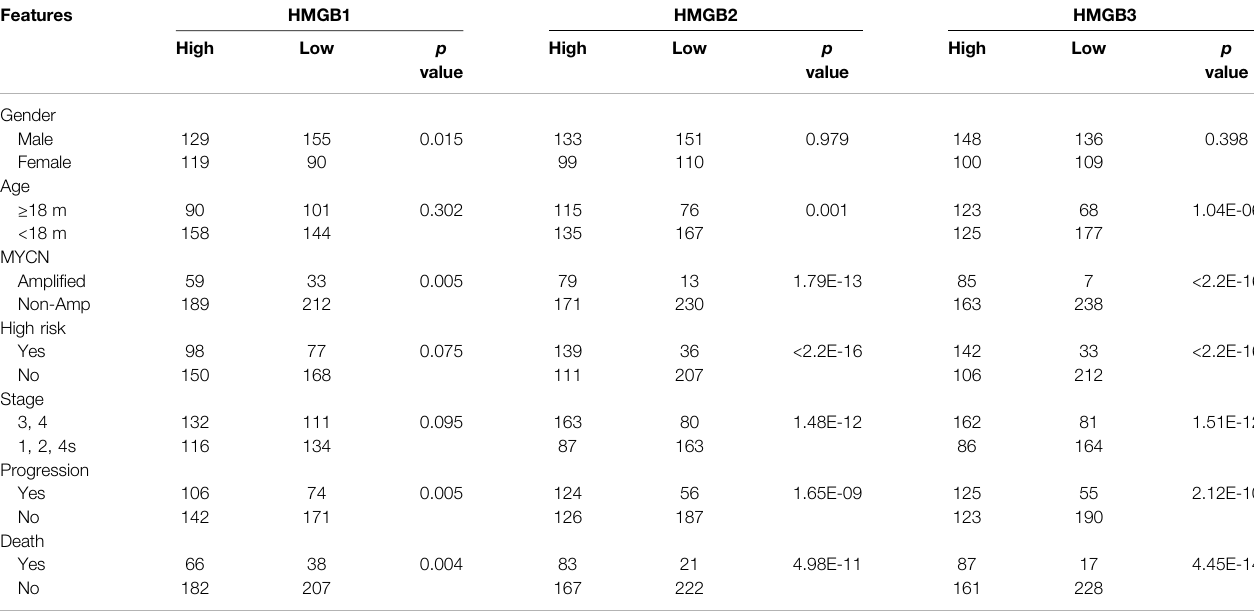
TABLE 3 | The relationship between HMGBs expression and clinicopathological features in NB patients. Features HMGB1 HMGB2